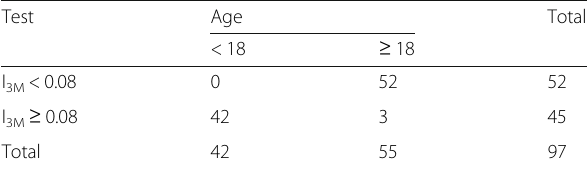
Table 3 Contingency table of the cutoff value ’ s performance for boys ( n ,